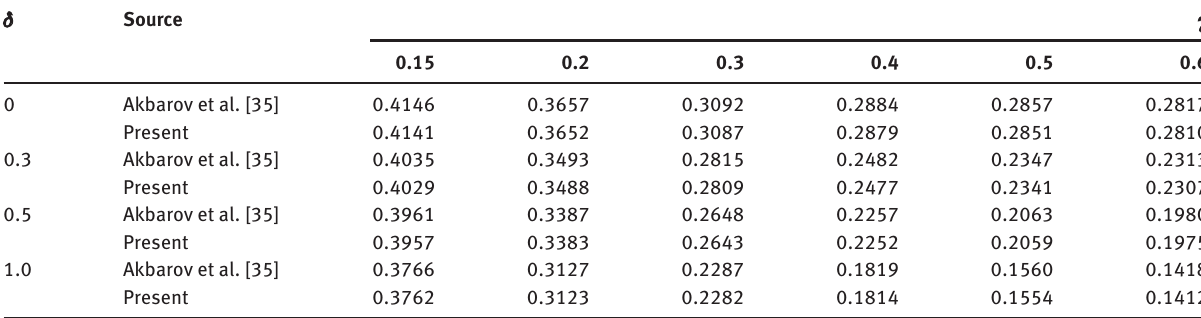
Table 2: Comparison of the dimensionless critical buckling loads for E (2) / E (1) = 5 with different δ and γ . δ Source